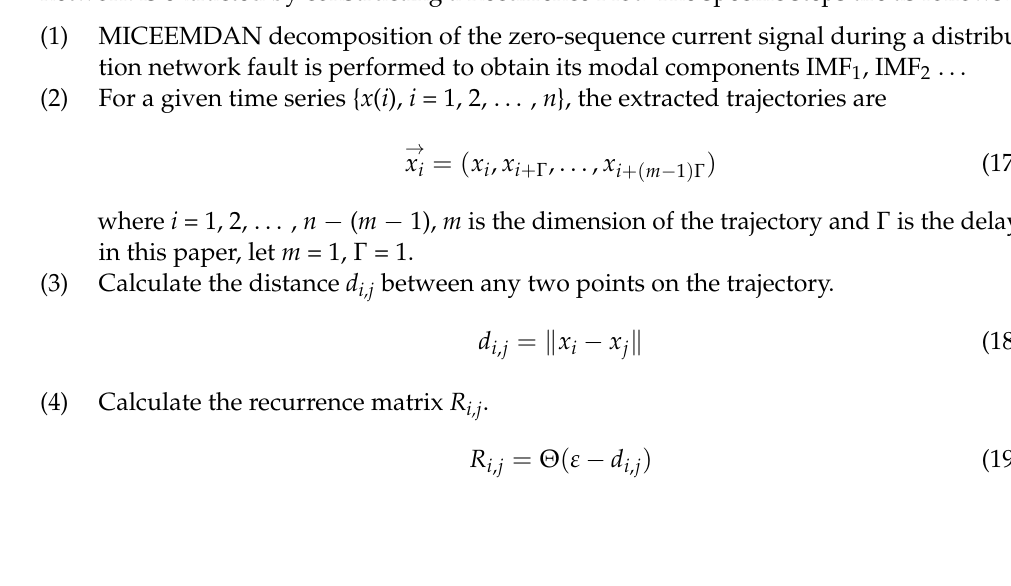
Figure 7. Hilbert–Huang spectrum: ( a ) ICEEMDAN; ( b ) MICEEMDAN.